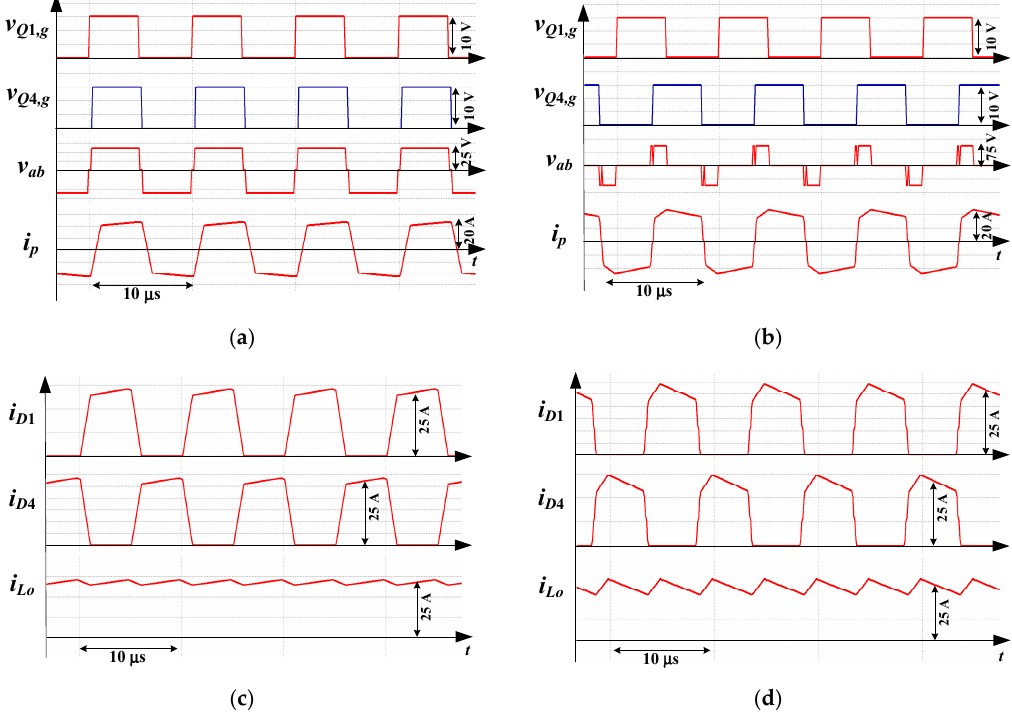
Figure 5. Simulated results in low input voltage range and full load ( a ) primary side waveforms at 25 V input ( b ) primary side waveforms at 75 V input ( c ) secondary side waveforms at 25 V input ( d ) secondary side waveforms at 75 V input.